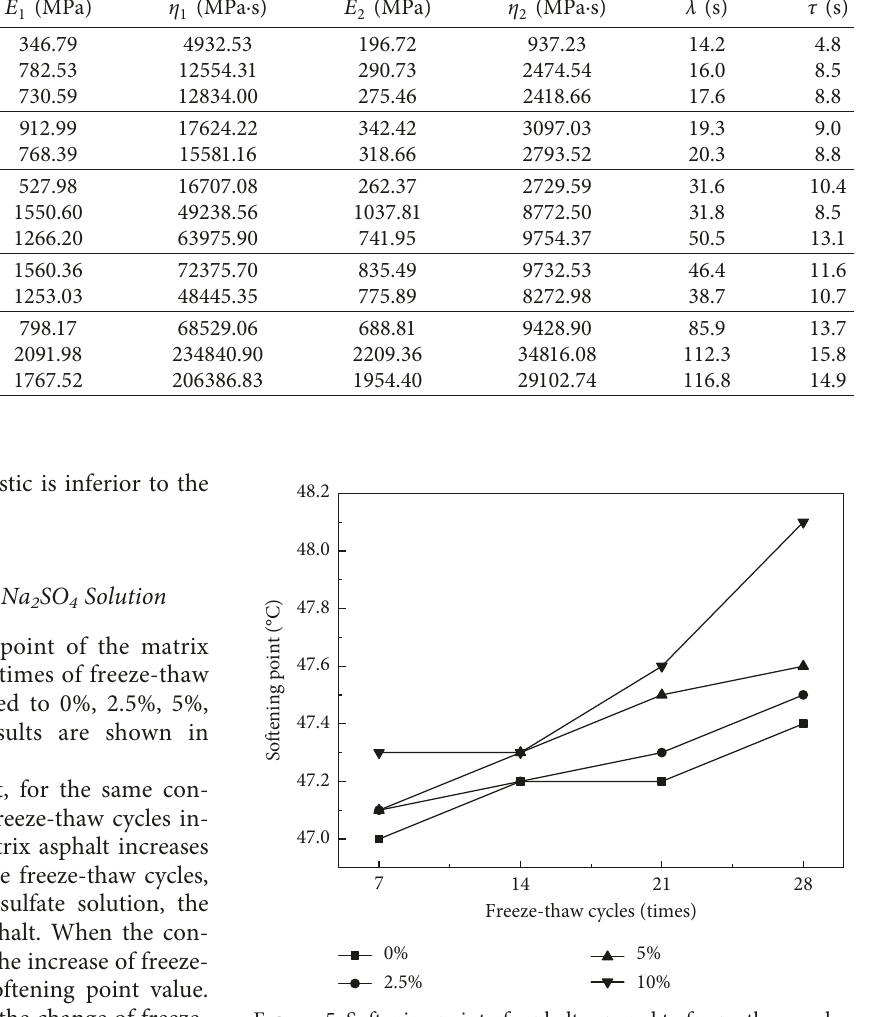
Figure 5: Softening point of asphalt exposed to freeze-thaw